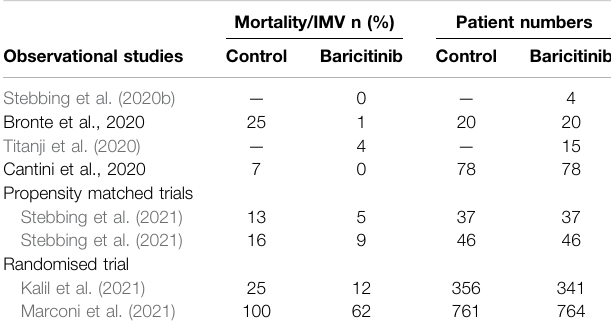
TABLE 5 | Summary of clinical ef fi cacy of baricitinib. Stebbing et al., 2020a, No controls, 4 patients; Bronte et al., 2020, with hydroxychloroquine, 8 mg/day baricitinib for 2 days, followed by 4 mg/day for 7 days, consecutive patients admitted with COVID; Titanji et al., 2020, no controls, 2 – 4 mg baricitinib 5 – 7 days with hydroxy-chloroquine, 15 moderate-critical patients; Cantini et al., 2020, moderate patients with lopinavir/ritonavir, 88% of those on baricitinib recovered after 14 days (control 14%); Stebbing et al., 2021 propensity matched patients, with antiviral medications including lopinavir/ritonavir; Kalil et al., 2021: Patients requiring high fl ow oxygen or non-invasive ventilation (ordinal groups 5 and 6), mortality at day 28, with remdesivir, median time to